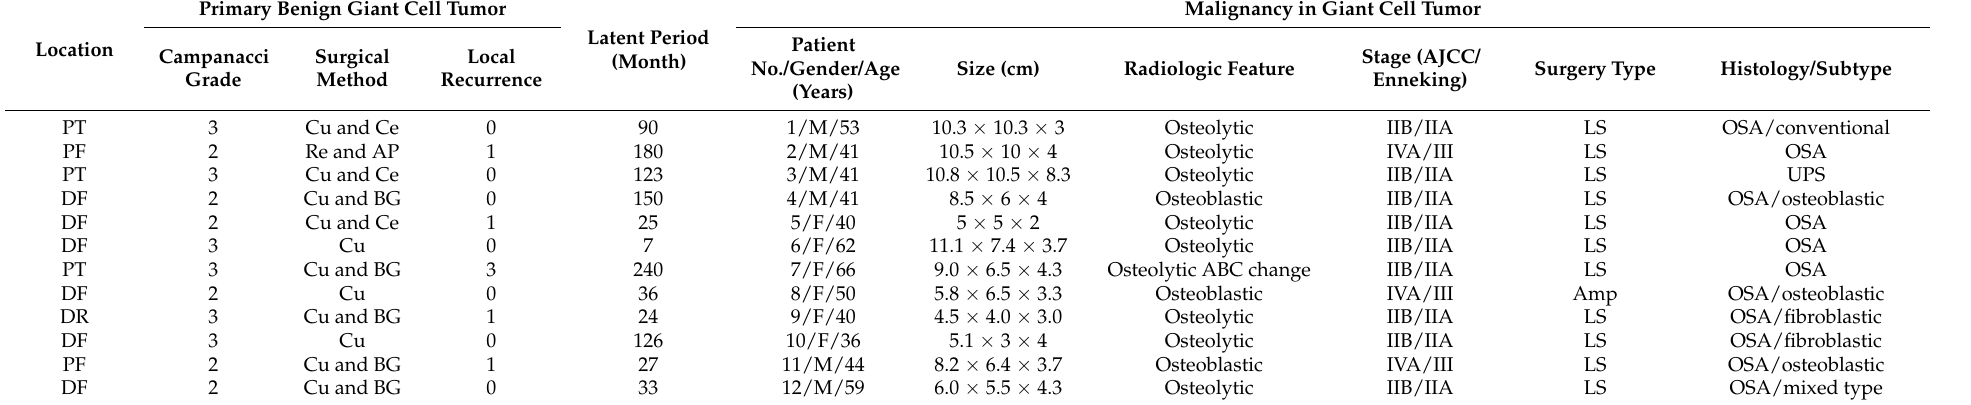
Table 1. Patient characteristics.